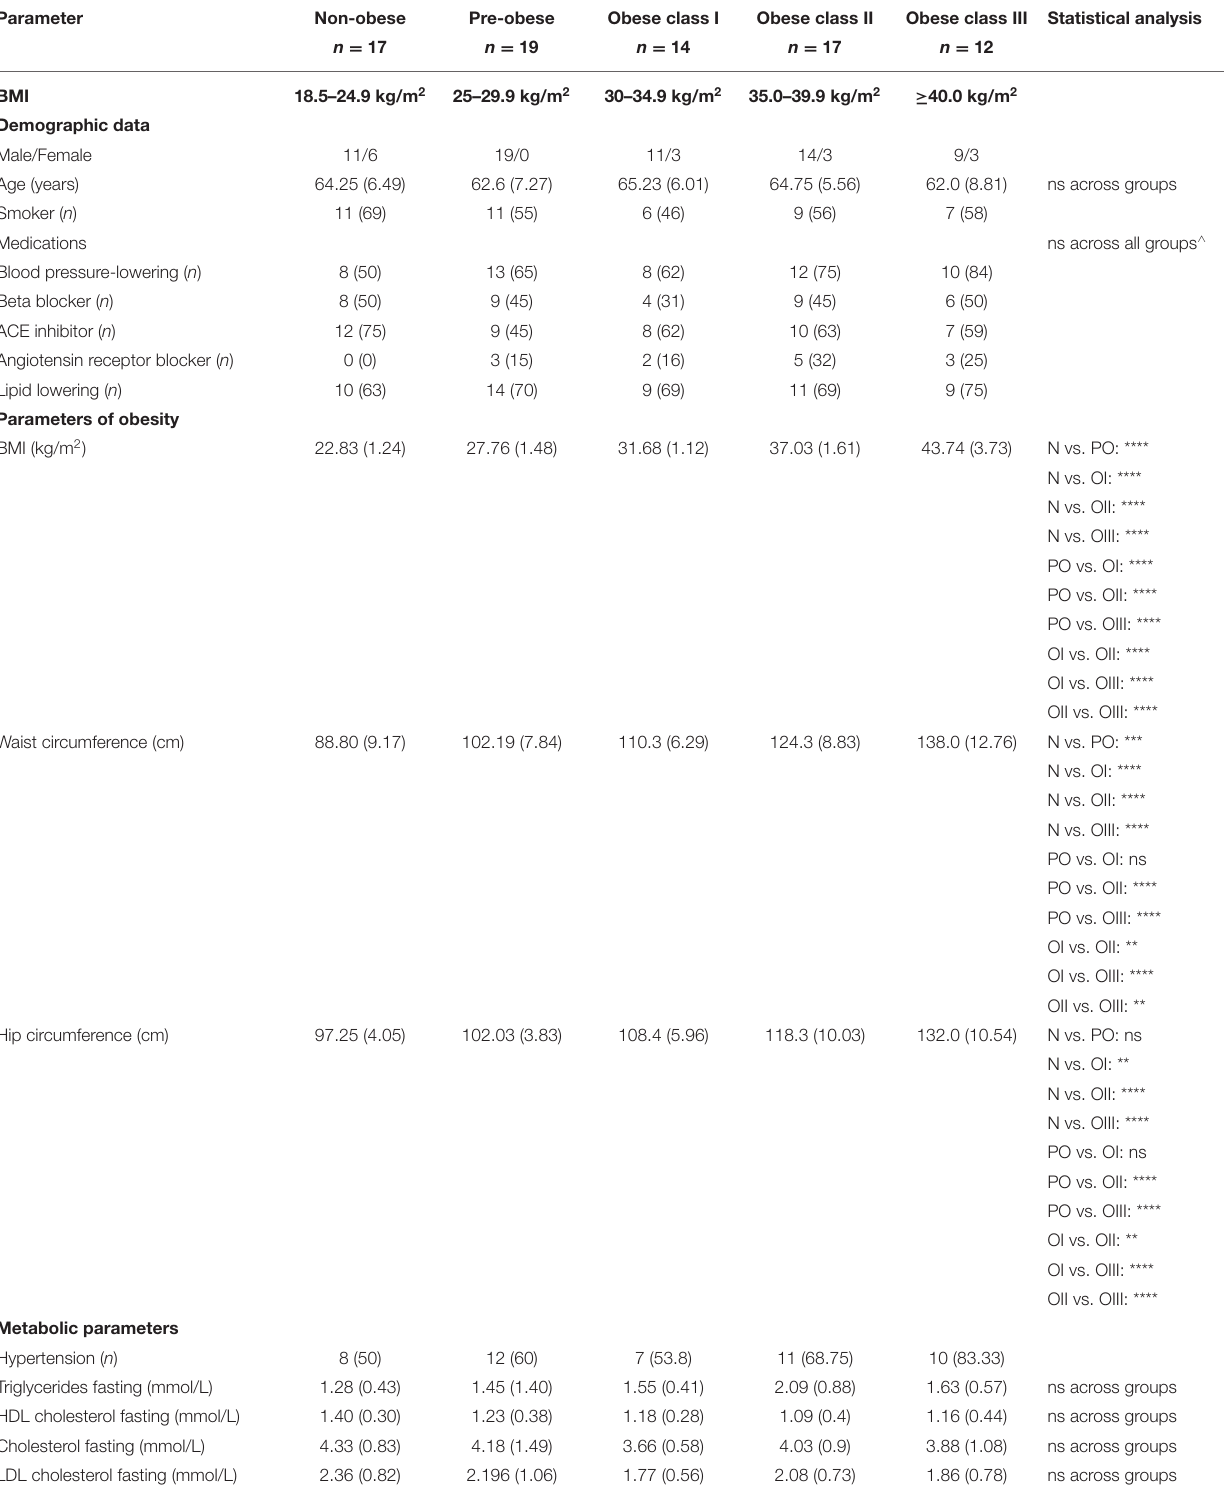
TABLE 1 | Patient characteristics and metabolic